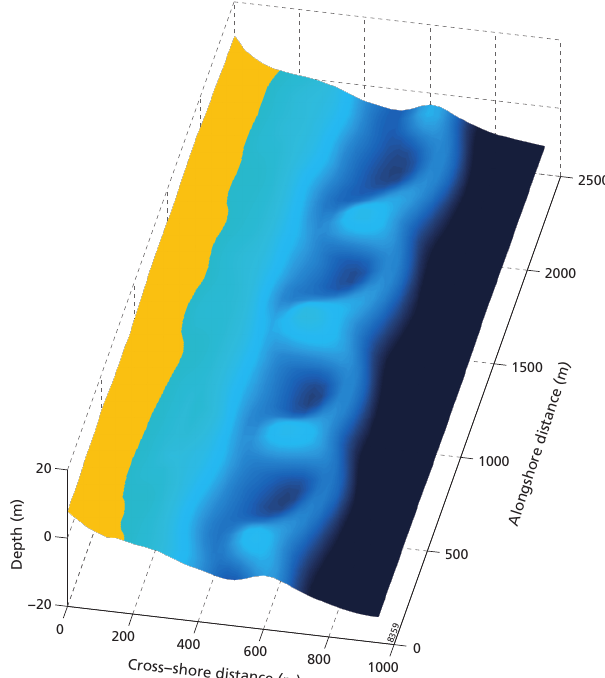
Figure 1. Bathymetry of a beach with a crescentic sandbar. This bathymetry was measured during the ECORS-Truc Vert 2008 field experiment (see Almar et al.